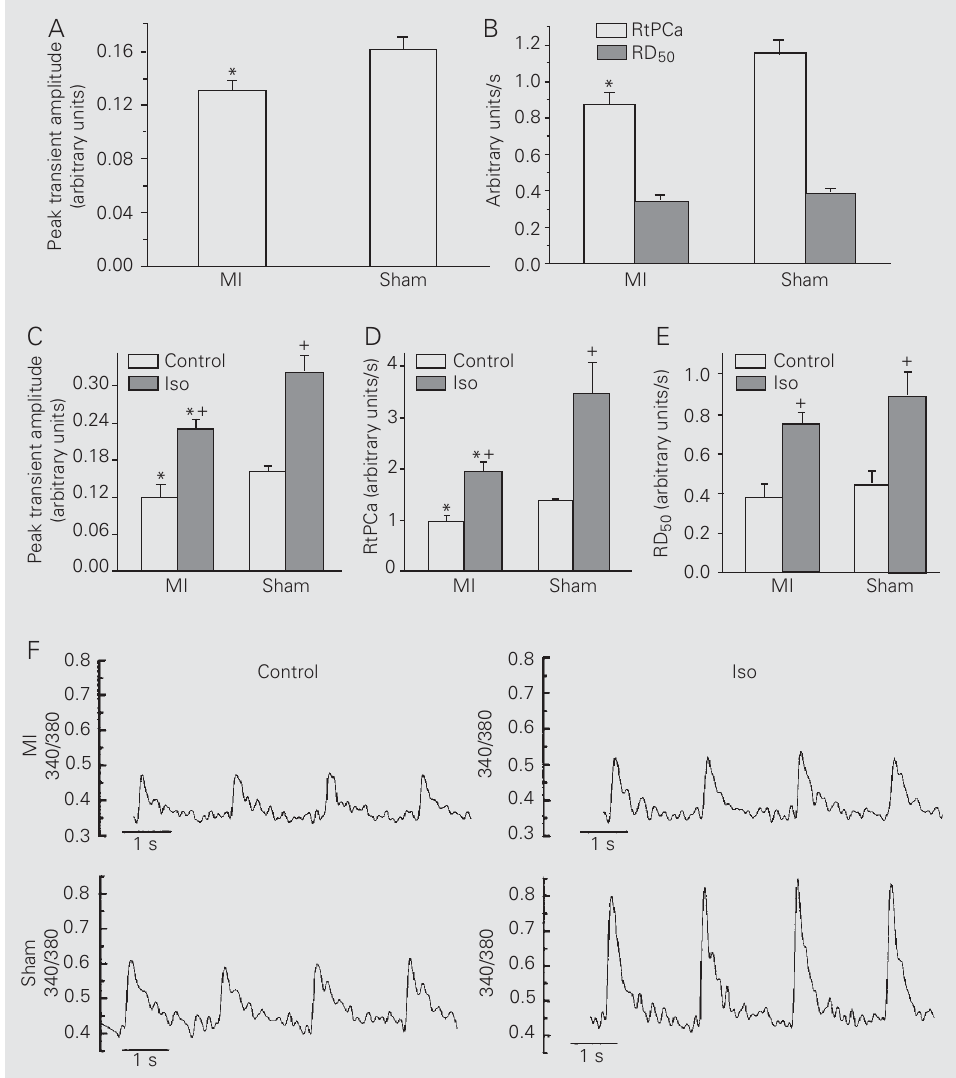
Figure 4. Cytoplasmic calcium ([Ca 2+ ] i ) transient parameters obtained from isolated ventricular myocytes loaded with fura 2-AM. A , Peak amplitudes of [Ca 2+ ] i transients measured from the resting level: 0.13 ± 0.007, N = 34, in postinfarction (MI) and 0.16 ± 0.009, N = 33, in sham myocytes (P = 0.01, unpaired Student t -test). B , Rates of increase to peak (RtPCa), and of decay to 50% amplitude (RD 50 ) of the [Ca 2+ ] i transients: RtPCa: 0.87 ± 0.0067, N = 34, in MI and 1.15 ± 0.075 units/s, N = 33, in sham (P<0.001) and RD 50 : 0.34 ± 0.028, N = 34, in MI and 0.38 ± 0.022 units/s, N = 33, in sham myocytes (P = 0.27, unpaired Student t -test). C , Peak transient amplitudes, D , RtPCa, and E , RD 50 of the [Ca 2+ ] i transients under control condition and in the presence of 1 µM isoproterenol in MI and sham myocytes. Isoproterenol induced an increase in peak amplitudes of the [Ca 2+ ] i transients from 0.12 ± 0.02 to 0.23 ± 0.01, N = 8, in MI and from 0.16 ± 0.01 to 0.32 ± 0.04, N = 7, in sham. RtPCa was increased in MI from 0.97 ± 0.13 to 1.94 ± 0.18 units/s, N = 8, and in sham from 1.36 ± 0.40 to 3.43 ± 0.63 units/s, N = 7; isoproterenol-induced increase in RD 50 was from 0.38 ± 0.07 to 0.75 ± 0.09 units/s, N = 8, in MI and from 0.45 ± 0.07 to 0.89 ± 0.13 units/s, N = 7, in sham. Measurements of [Ca 2+ ] i transients were always performed first under control condition and then in the presence of the drug in the same cell. Each cell was exposed only once to isoproterenol to avoid desensitization. F , Sample records from one MI and one sham cell, bathed in control saline (control) and at 3rd minute of exposure to 1 µM isoproterenol. *P<0.05 for comparisons between MI and sham, and + P<0.05 for comparisons between isoproterenol and control (unpaired Student t -test). Iso,